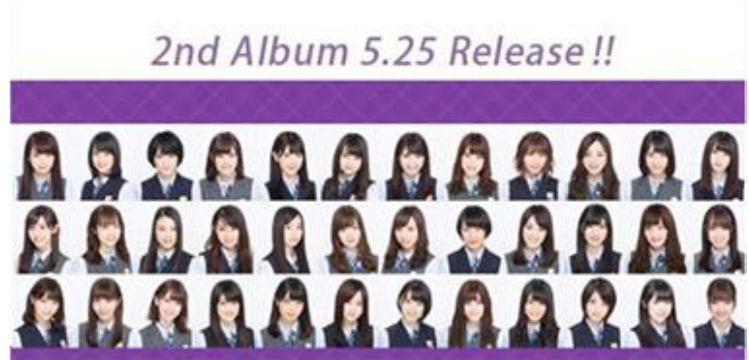
Fig. 1 List of Nogizaka46 member as for February 2016